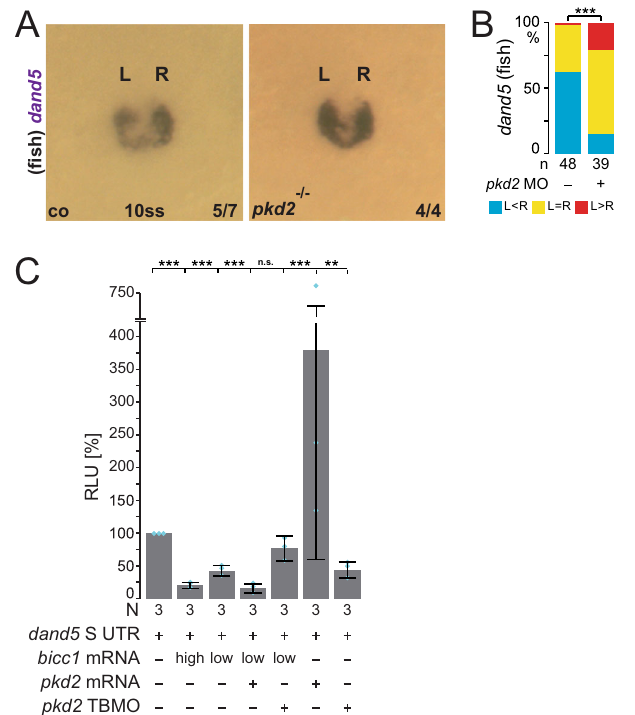
Fig. 7 Pkd2 function modi fi es Bicc1-mediated translational repression of dand5 . A Absence of dand5 repression in maternal zygotic (MZ) pkd2 mutant zebra fi sh at 10 somite stage (ss). B Quanti fi cation of dand5 asymmetry in controls (co) and pkd2 morphant (1 – 4 ng) zebra fi sh. Asymmetry was determined by picture analysis using ImageJ. Number (n) represents the number of analyzed specimens. Statistical analyses were done with one-sided Pearson ’ s chi-square test. C Animal cap luciferase reporter assay of full-length dand5.S 3 ′ -UTR (cf. Figure 1A). The reporter construct was injected as mRNA either alone or in combination with high or low dose bicc1 mRNA, pkd2 mRNA or pkd2 TBMO. Gradual repression upon co-injection of high or low concentrations of bicc1 mRNA was observed.